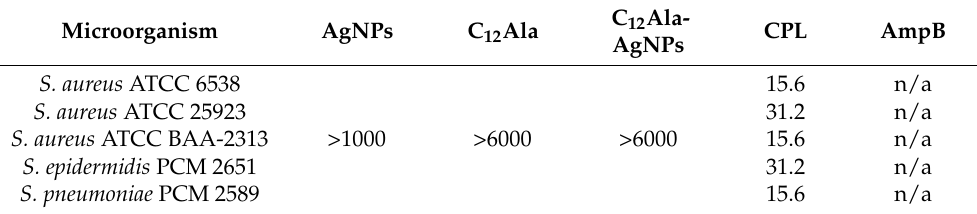
Table 1. Assessment of antibacterial and antifungal properties of AgNPs, and C 12 Ala, as well as C 12 Ala-AgNPs, gels. MIC values expressed in µ g/mL are presented. Chloramphenicol (CPL)